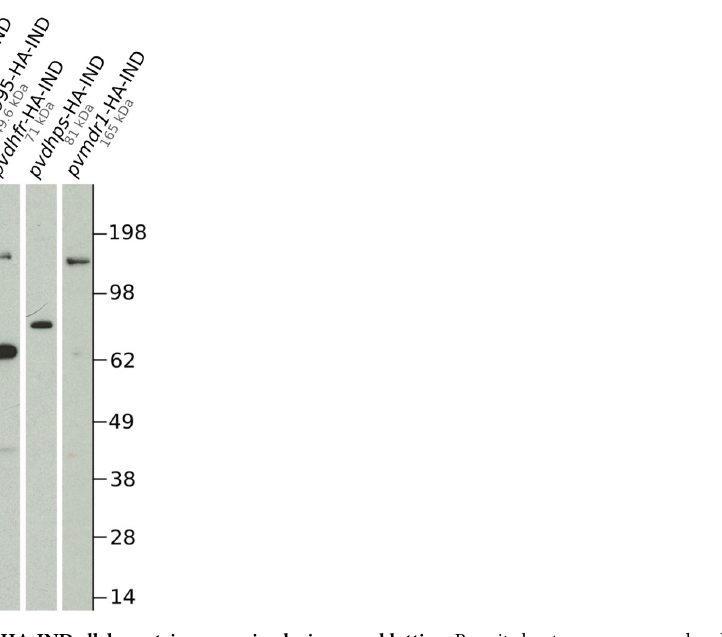
Fig 1. Confirmation of -HA-IND allele protein expression by immunoblotting. Parasite lysates were prepared and run in denaturing conditions as described. Proteins were detected with an α -HA antibody. A lysate of the parent P. knowlesi strain A1-H.1 was used as a negative